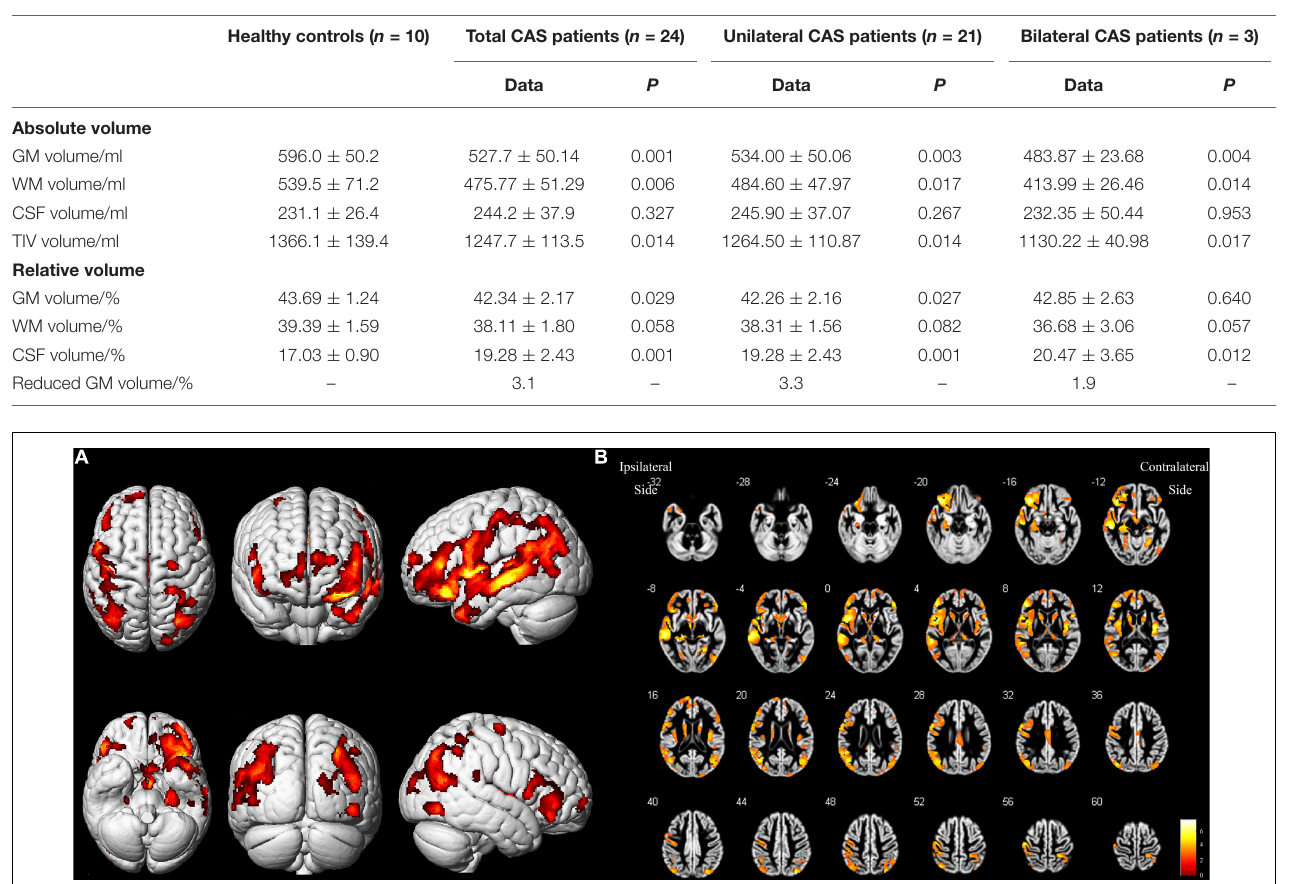
TABLE 3 | Brain volumes of different parts in CAS patients and healthy controls.